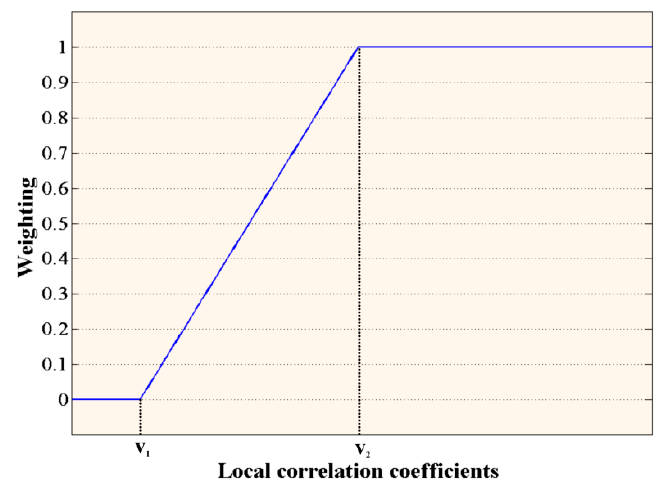
Figure 5. Demonstration of weighting operator.